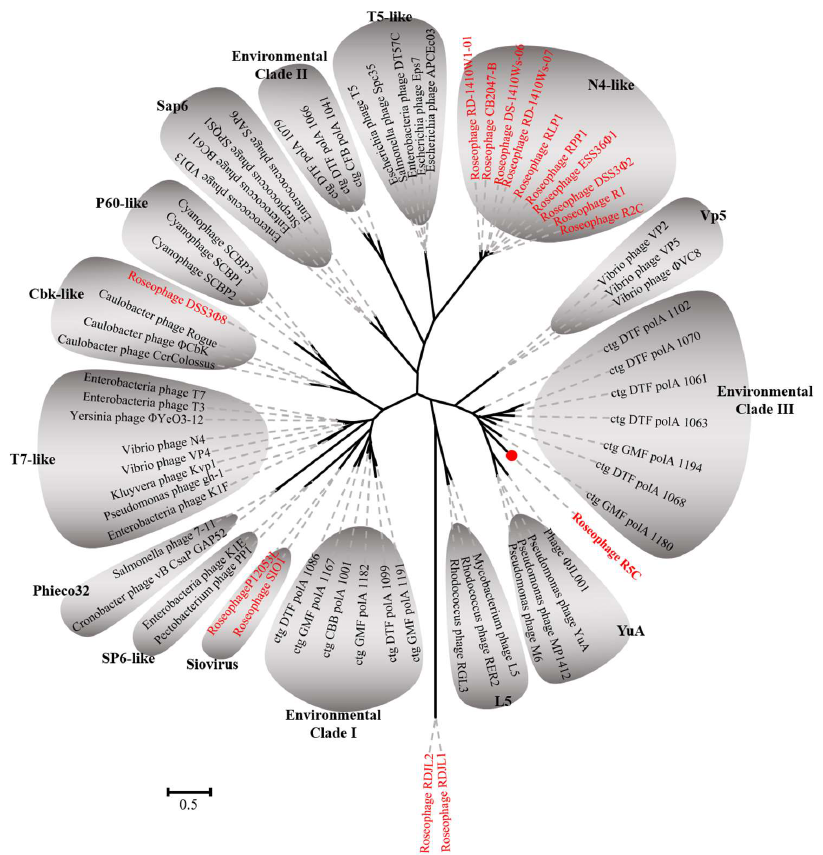
Figure 5. Unrooted maximum likelihood phylogenetic tree of DNA polymerase I of bacteriophages. Red color represents the roseophages. The sequences were aligned by ClustalW and Bootstrap = 1000. Viruses 2019 , 11 , 734; doi:10.3390 /